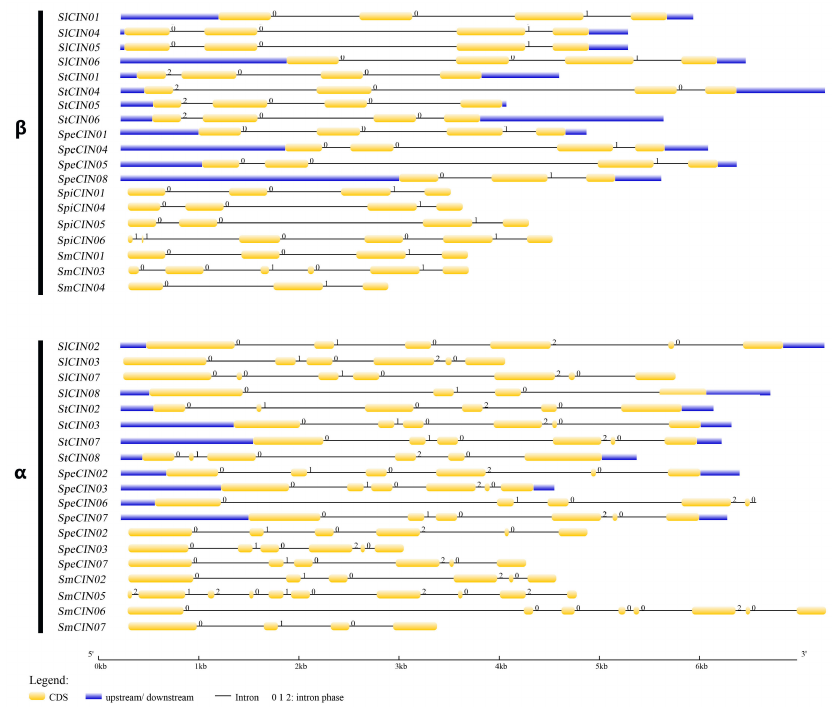
Figure 5. Exon–intron structure of 38 CINs in Solanum . Introns shown as black lines, and exons shown as yellow boxes. Upstream or downstream untranslated sequences represented by blue boxes. Phase 0 represents intron located between two codons; phase 1 represents intron inserted into the first base of a codon; phase 2 represents intron inserted / interrupt into the second base of a codon. Scale is shown at the bottom of the